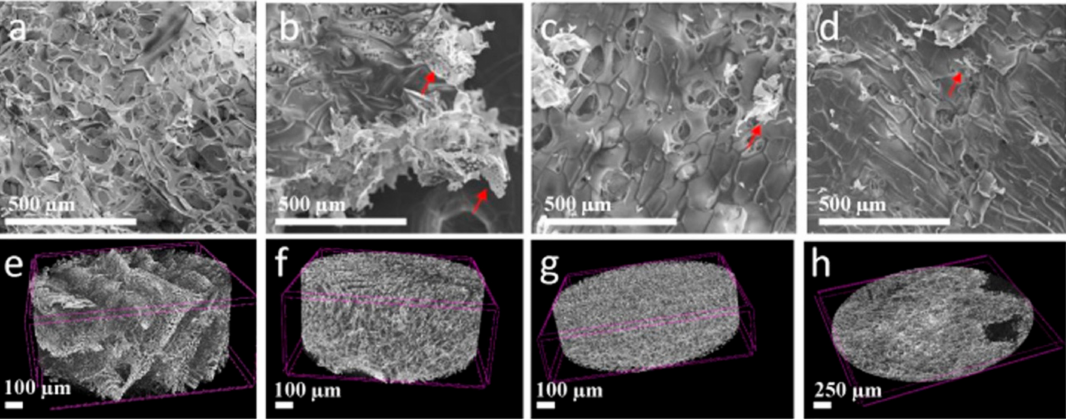
Figure 3. SEM and micro-CT images of the ( a , e ) reference CH / SHA matrix nanocomposite as well as modified with ( b , f ) 1 wt.%, ( c , g ) 5 wt.%, and ( d , h ) 10 wt.% of 2D Ti 3 C 2 T x MXene